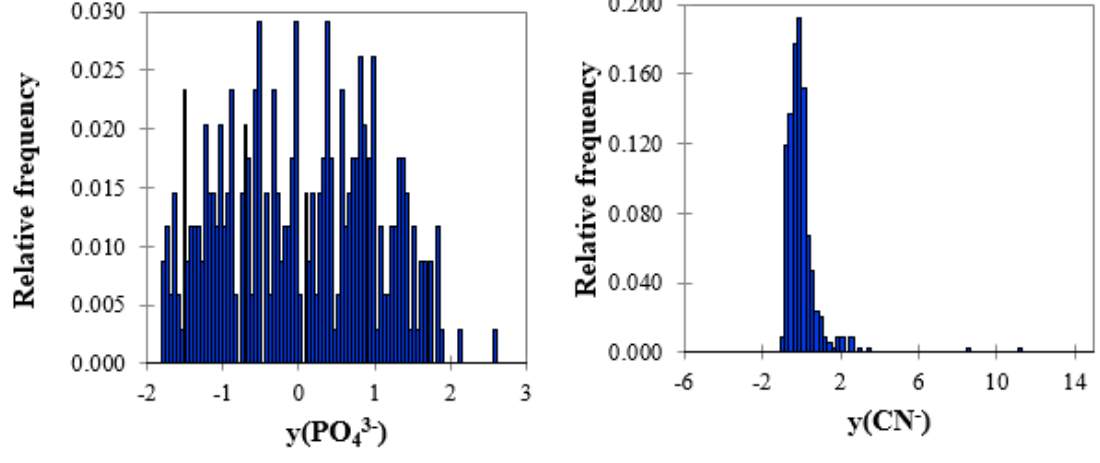
Figure 1. Histograms of phosphate and cyanide.